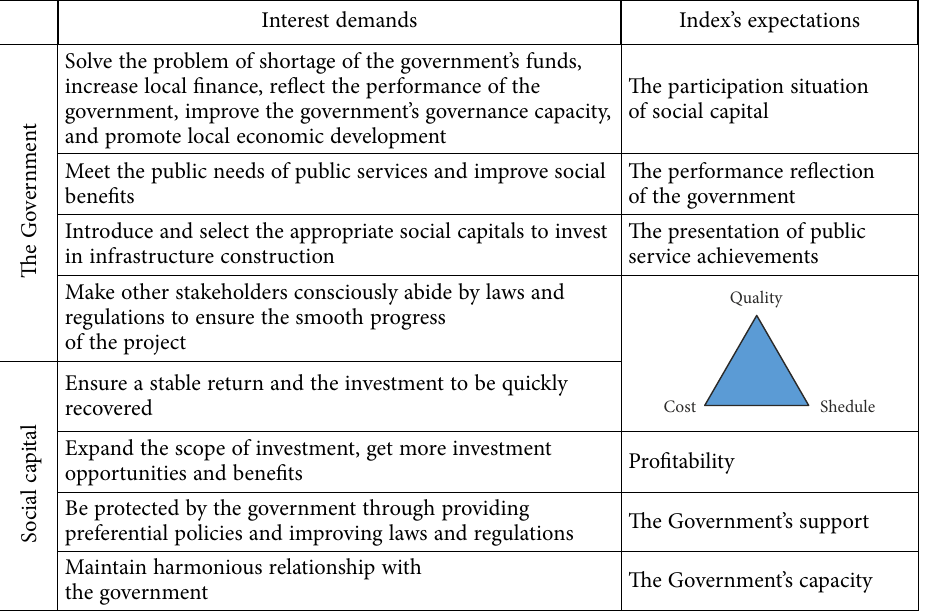
Table 1. The interest demands and the index’s expectations of the government and social capital Interest